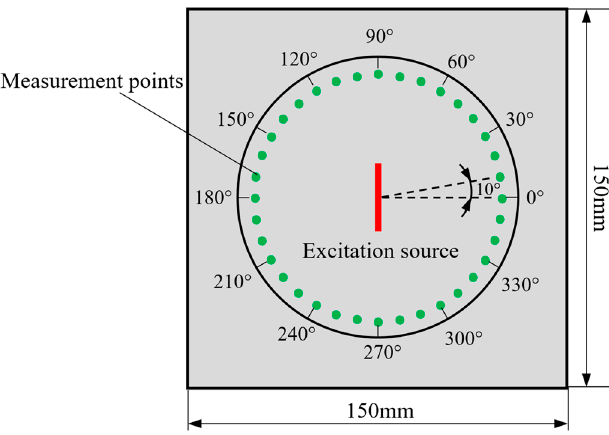
Figure 2. Layout of the line source and measurement points.